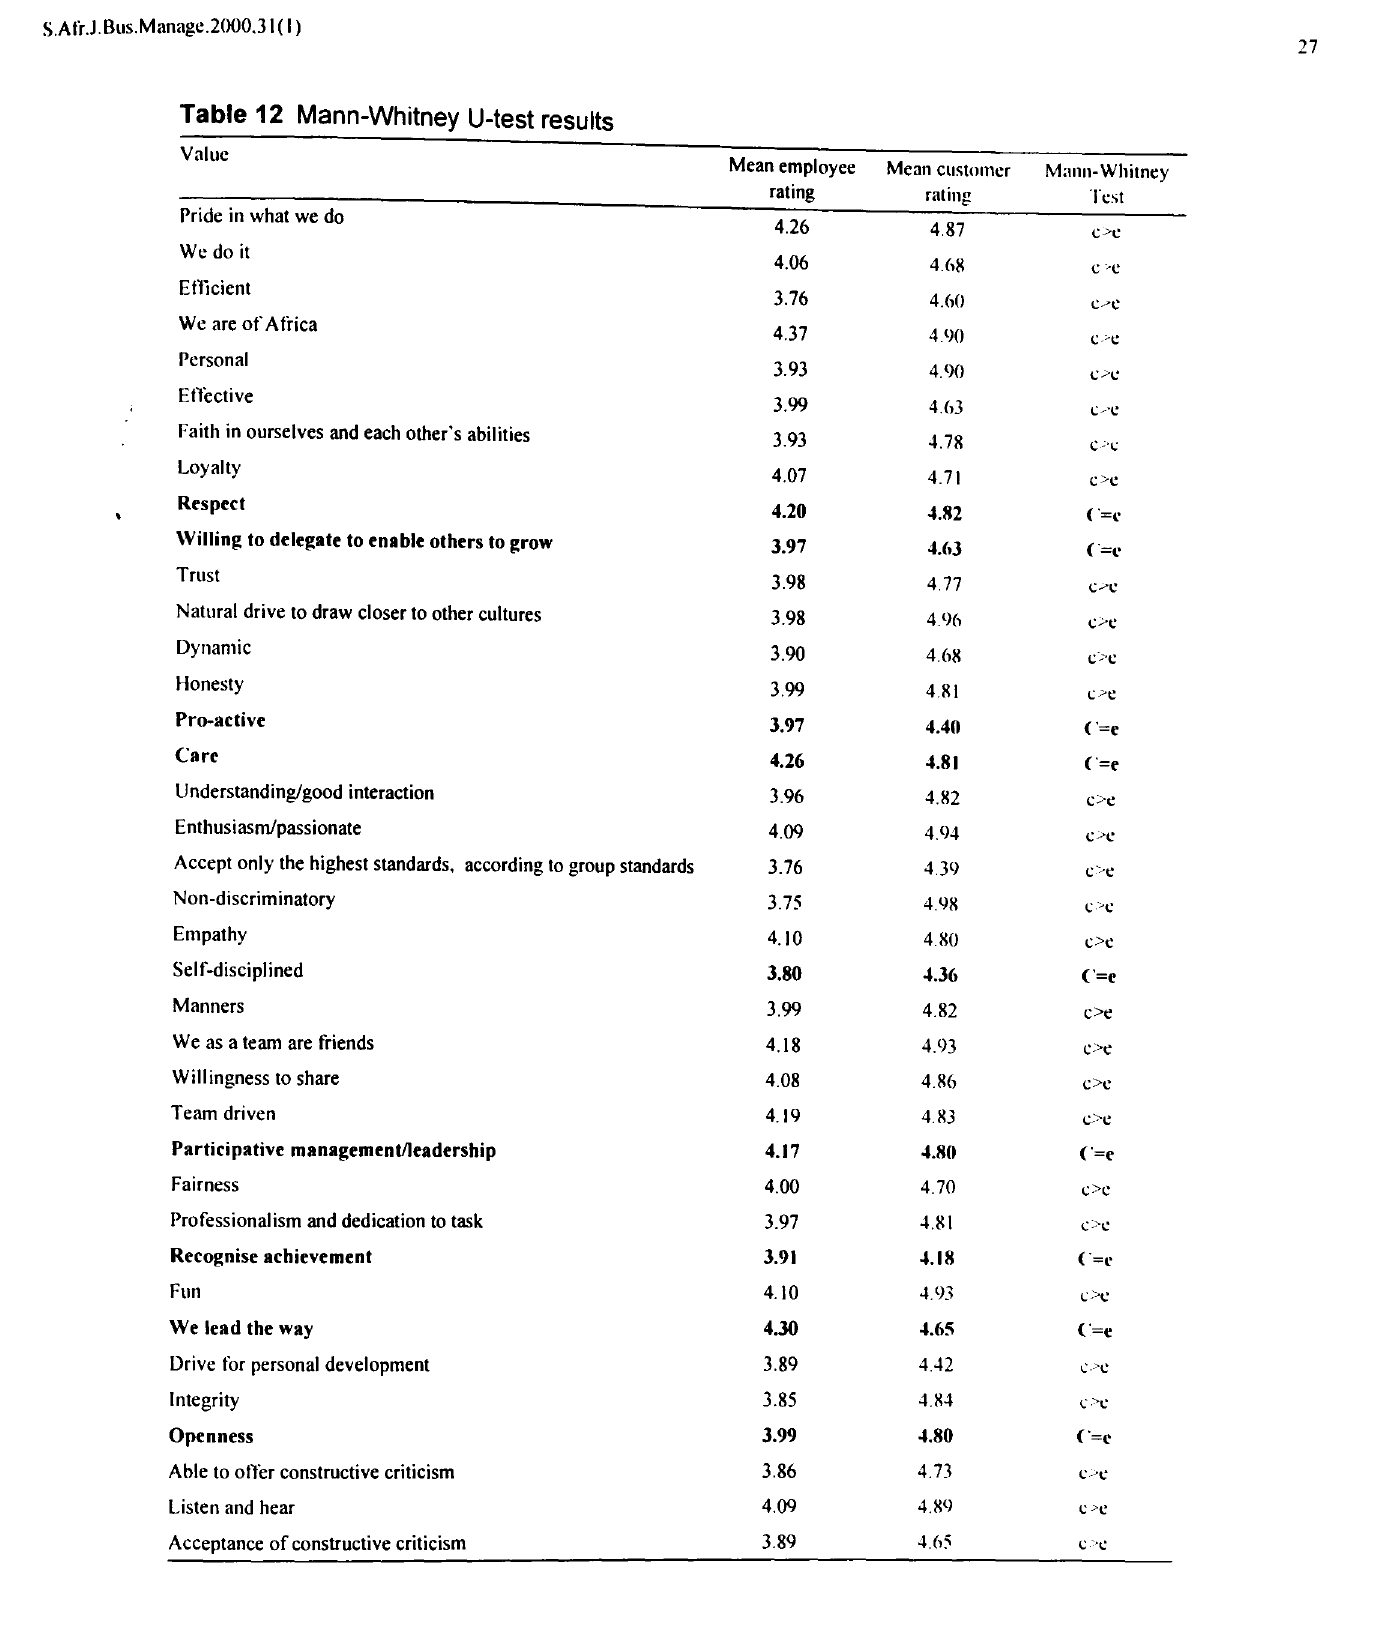
Table 12 Mann-Whitney U-test